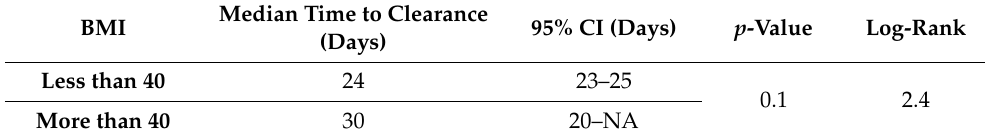
Table 7. Time to viral clearance in relation to patients’ BMI of more than 40 versus less than 40.